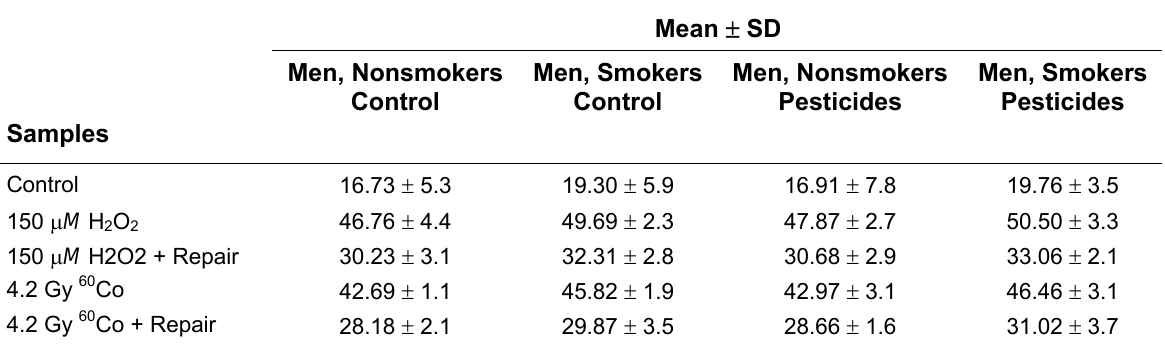
Mean Values of DNA Damage as Measured by Image Analysis System in the Four